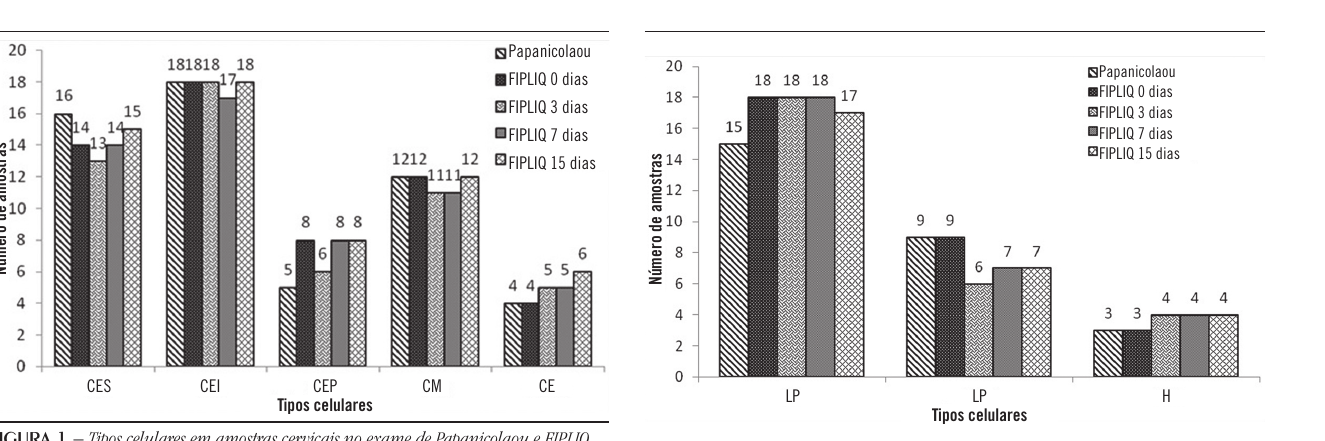
figura 1 − Tipos celulares em amostras cervicais no exame de Papanicolaou e FIPLIQ após 0, 3, 7 e 15 dias de preservação celular Não houve diferença estatisticamente significante (teste z , p = 0,05). FIPLIQ: fosfato de formaldeído-isopropanol; CES: células escamosas superficiais; CEI: células escamosas intermediárias; CEP: células epiteliais parabasais; CM: células metaplásicas; CE: células endocervicais.